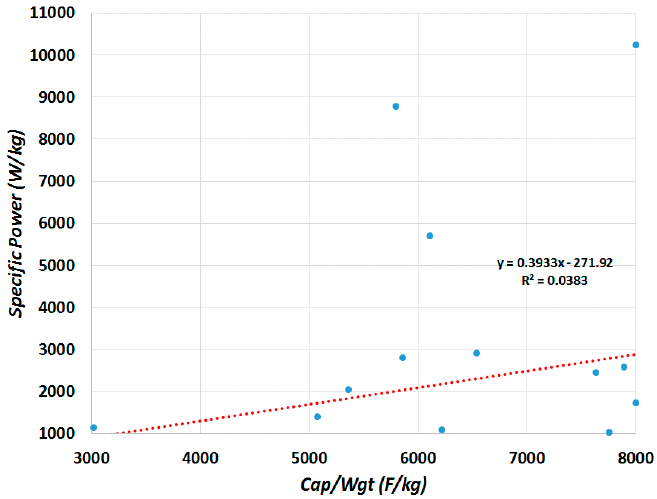
Figure 6. Specific power vs. specific capacitance (W/F) showing the power increasing slightly with the capacitance due to lower losses for bigger capacitors which have small ESRs due to the packaging.